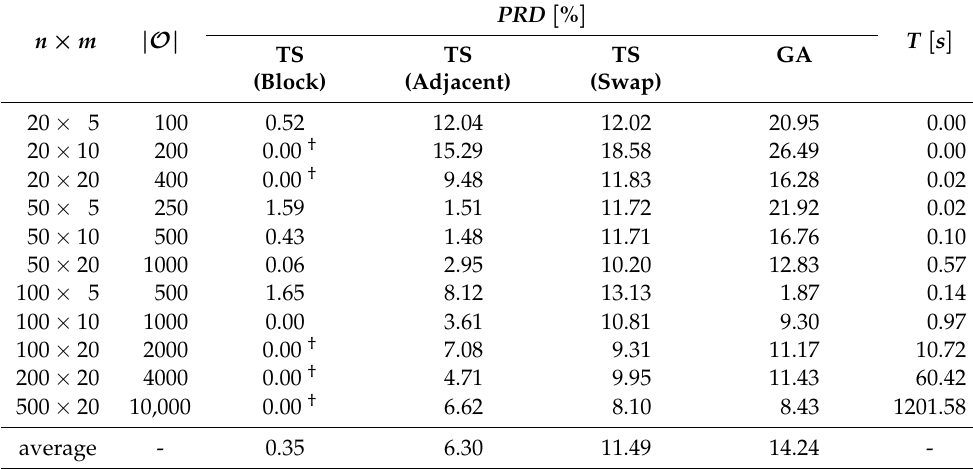
Table 4. Average PRD and running times T for the TS method with block swap, adjacent swap, and swap neighborhoods as well as the GA method for instances from set